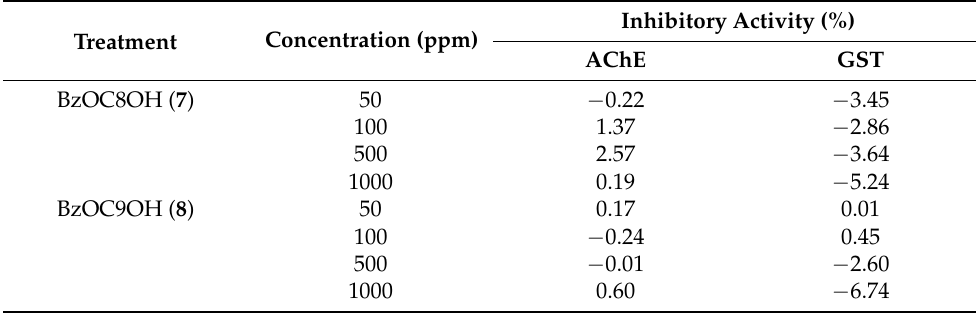
Table 3. Acetylcholinesterase (AChE) and glutathione S -transferase (GST) inhibitory activity